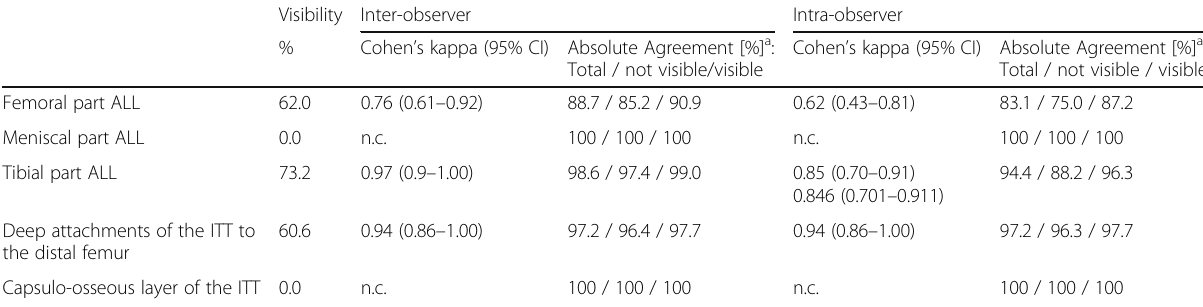
Table 1 Inter- and intra-observer reproducibility results for the different parts of the ALL and the deep ITT structures